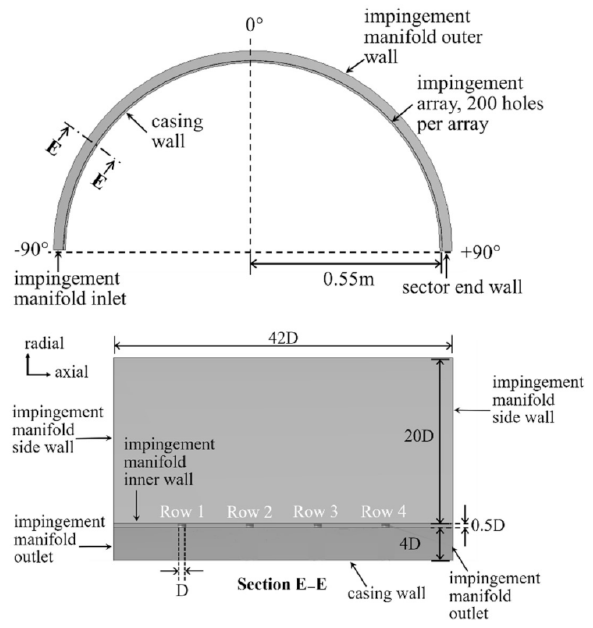
Figure 4. Single–entry ACC system geometry for CFD